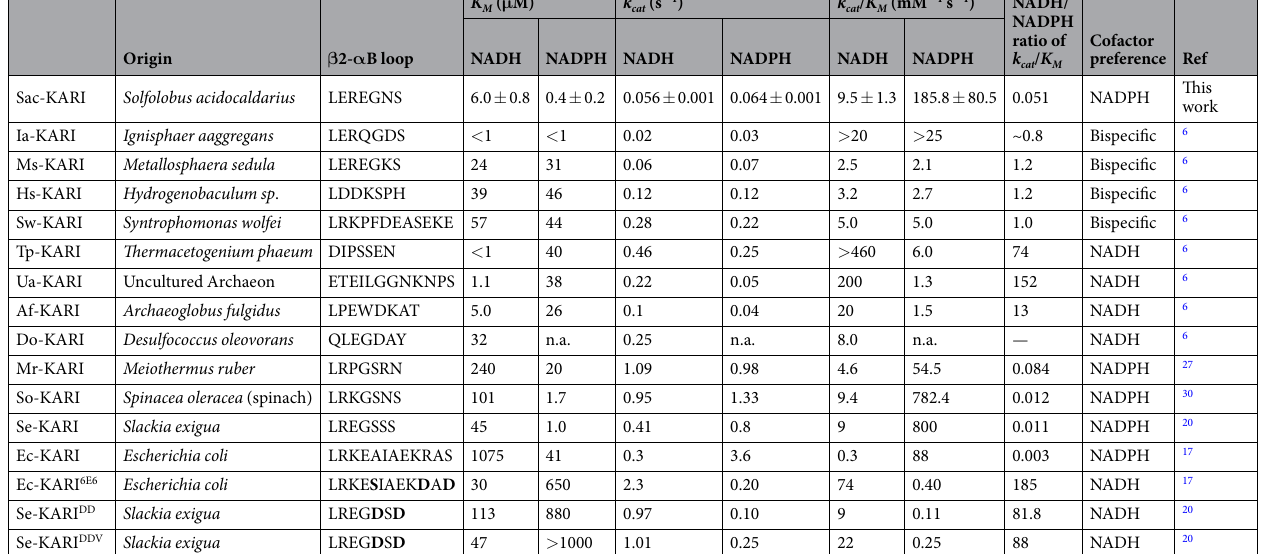
Table 3. Kinetic parameters of KARI variants determined using NADPH or NADH with saturating concentrations of 2 S -AL as substrate. Ec-KARI 6E6 mutant: A71S, R76D, S78D, Q110V; Se-KARI DD mutant: S61D, S63D; Se-KARI DDV mutant: S61D, S63D, I95V. Sac-KARI: The Michaelis-Menten constants for